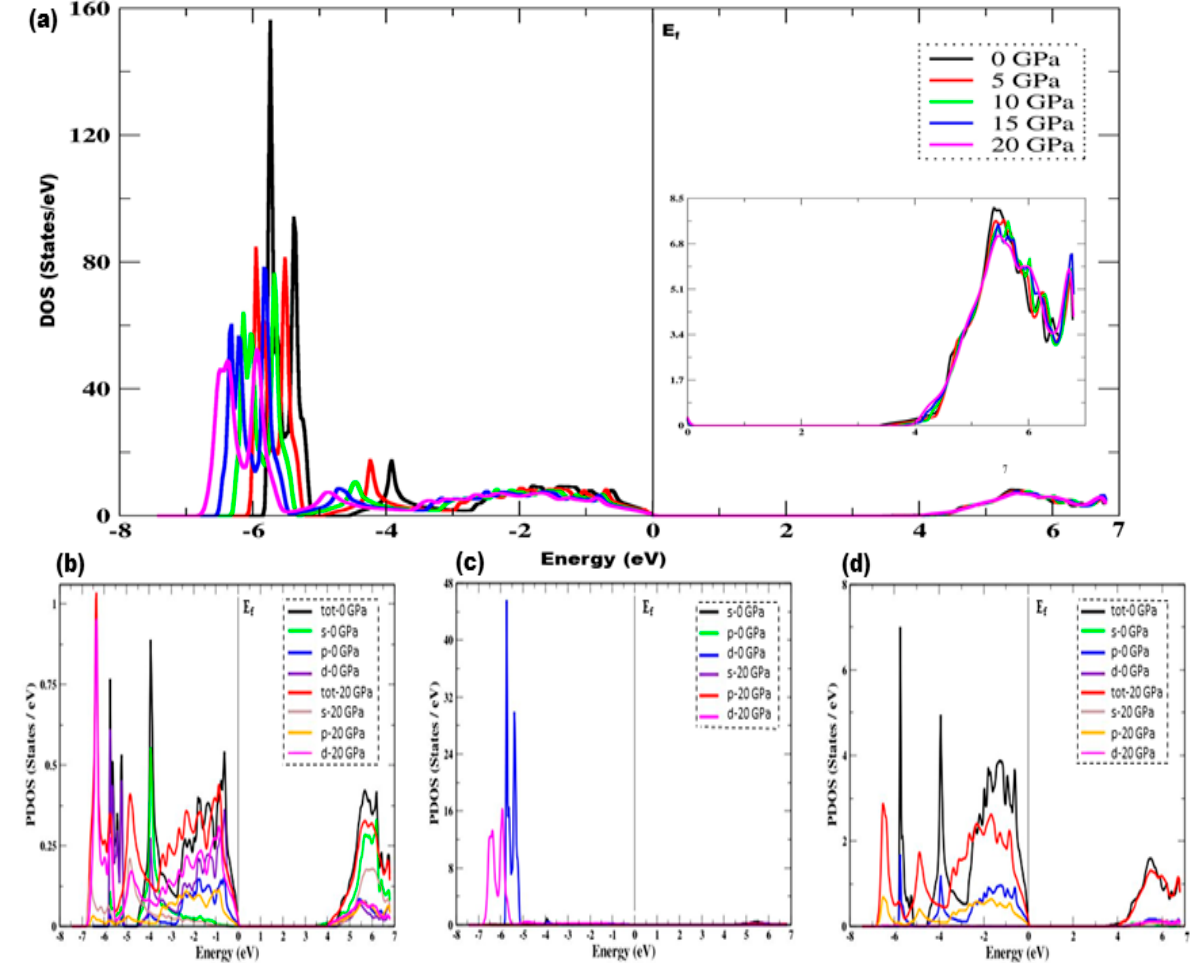
Figure 3. Density of states under the effect of pressure, ( a ) total density of states of Cd 0.25 Zn 0.75 S alloy, ( b ) partial density of states of Cd-atom, ( c ) partial density of states of S-atom, and ( d ) partial density of states of Zn-atom. The inset in ( a ) depicts a zoom of the conduction band around the Fermi level to display the variations in bandgap (right side) under the influence of pressure.